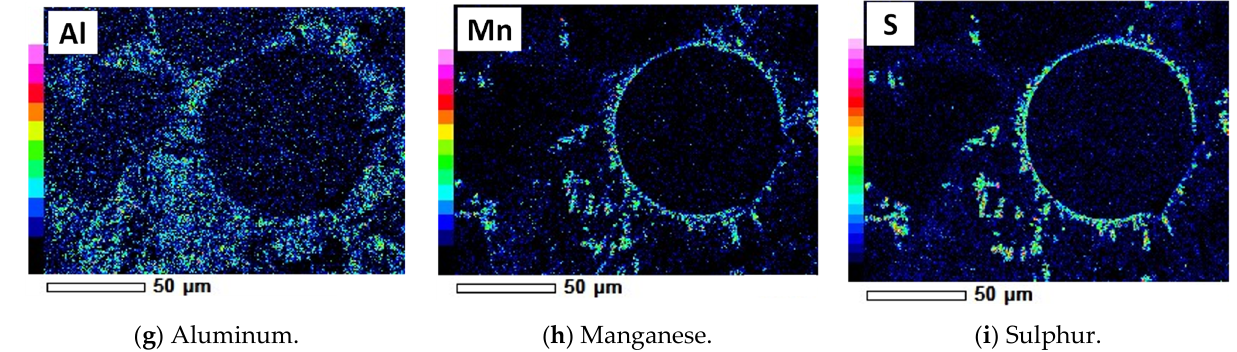
Figure 11. SEM-EDS elemental mapping of slag from the carbothermic reduction of the ilmenite concentrate at 15% Na 2 CO 3 addition, initial temperature of 1300 ◦ C, final temperatures of 1500 ◦ C, and heating rate of 6.6 ◦ C/min (pattern G).